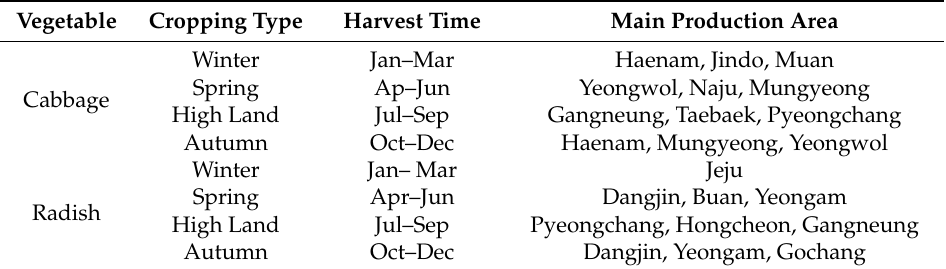
Table 3. Cropping type’s harvest time and main production